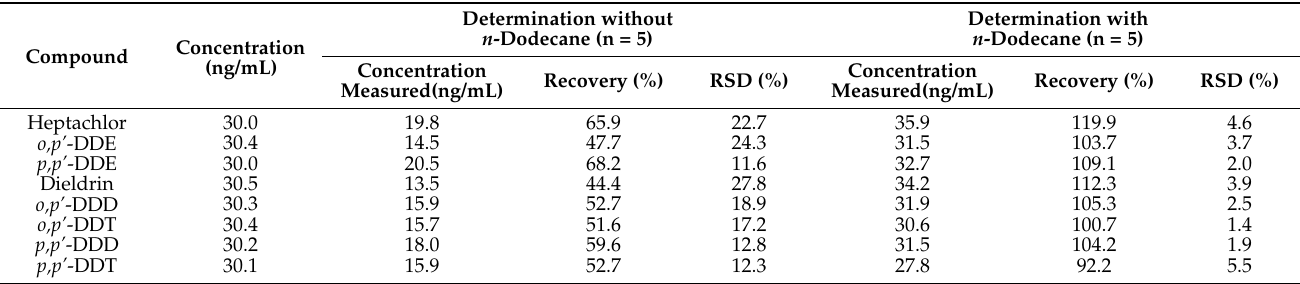
Table 6. The effect of n-dodecane addition on recovery and